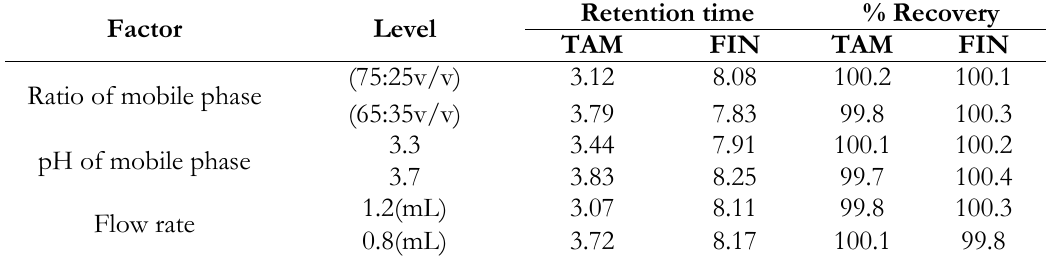
Table V. Robustness study Factor Level